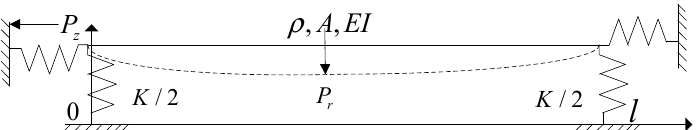
Figure 3. Lateral vibration diagram of beam model FLH.